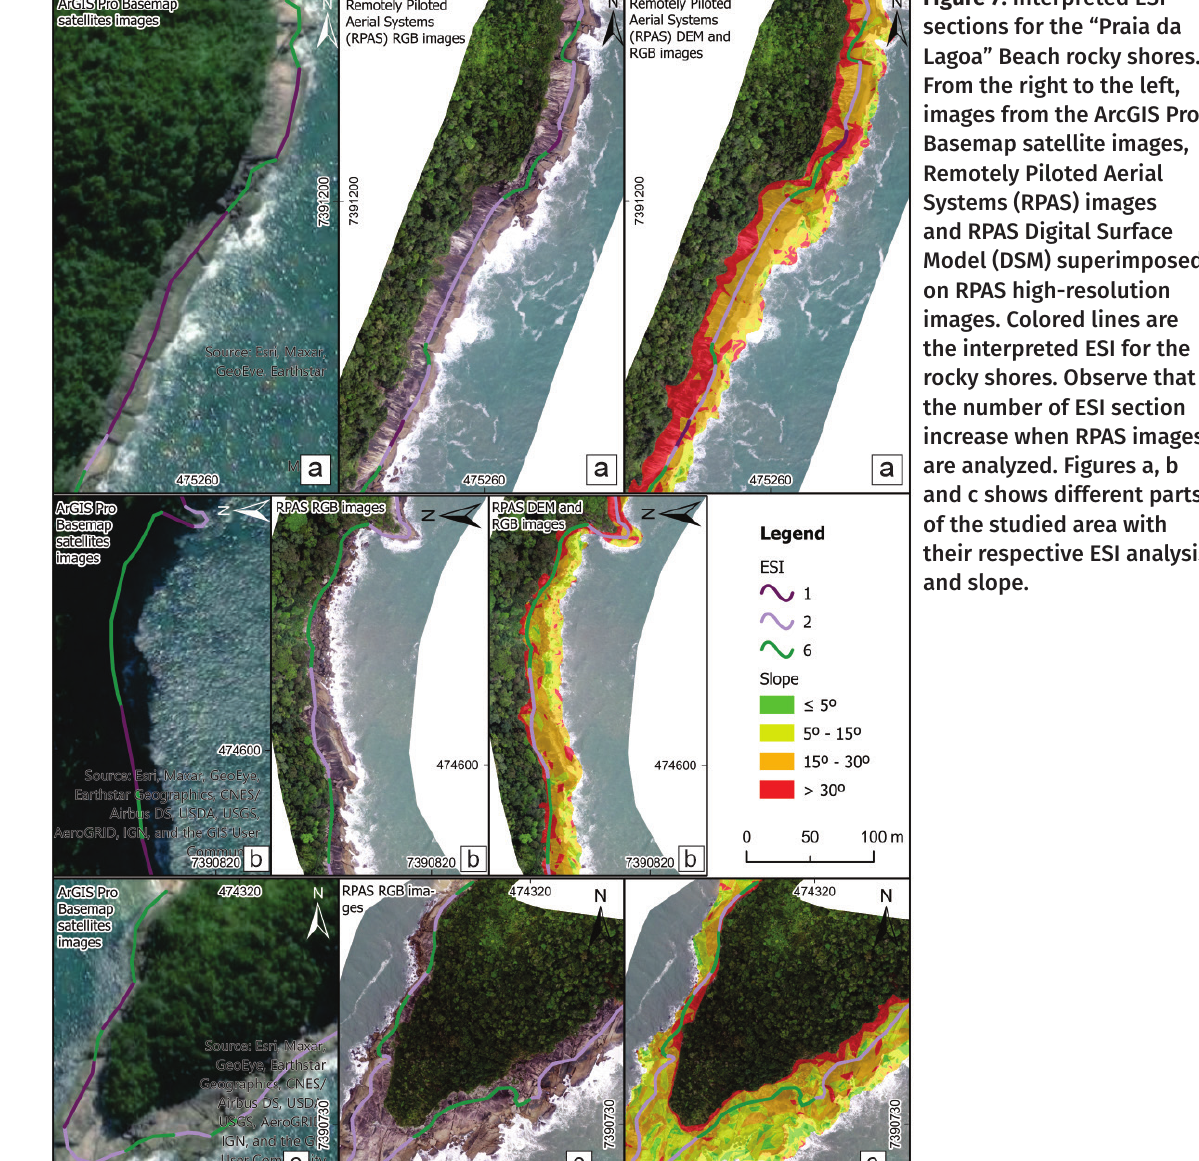
Figure 7. Interpreted ESI sections for the “Praia da Lagoa” Beach rocky shores. From the right to the left, images from the ArcGIS Pro Basemap satellite images, Remotely Piloted Aerial Systems (RPAS) images and RPAS Digital